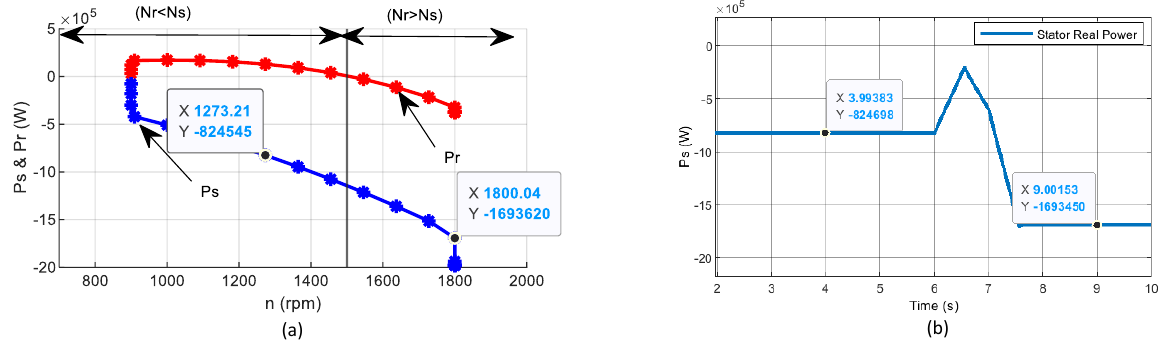
Figure 11. ( a ) Calculated stator real power; ( b ) Stator real power of the designed system.